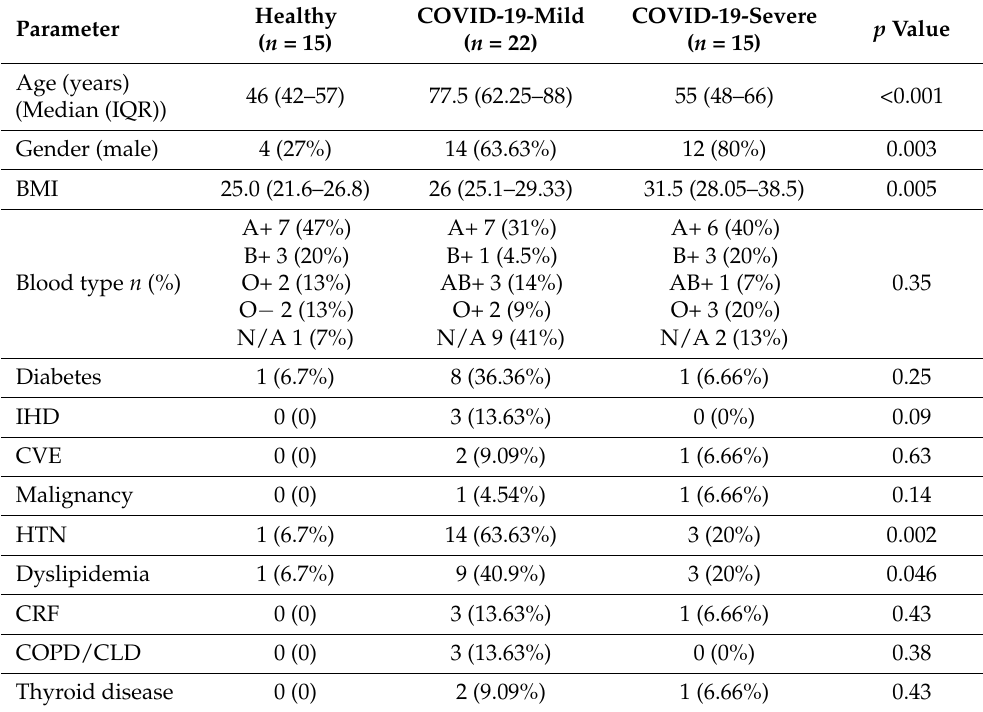
Table 1. Demographic and health characteristics of the participants in the